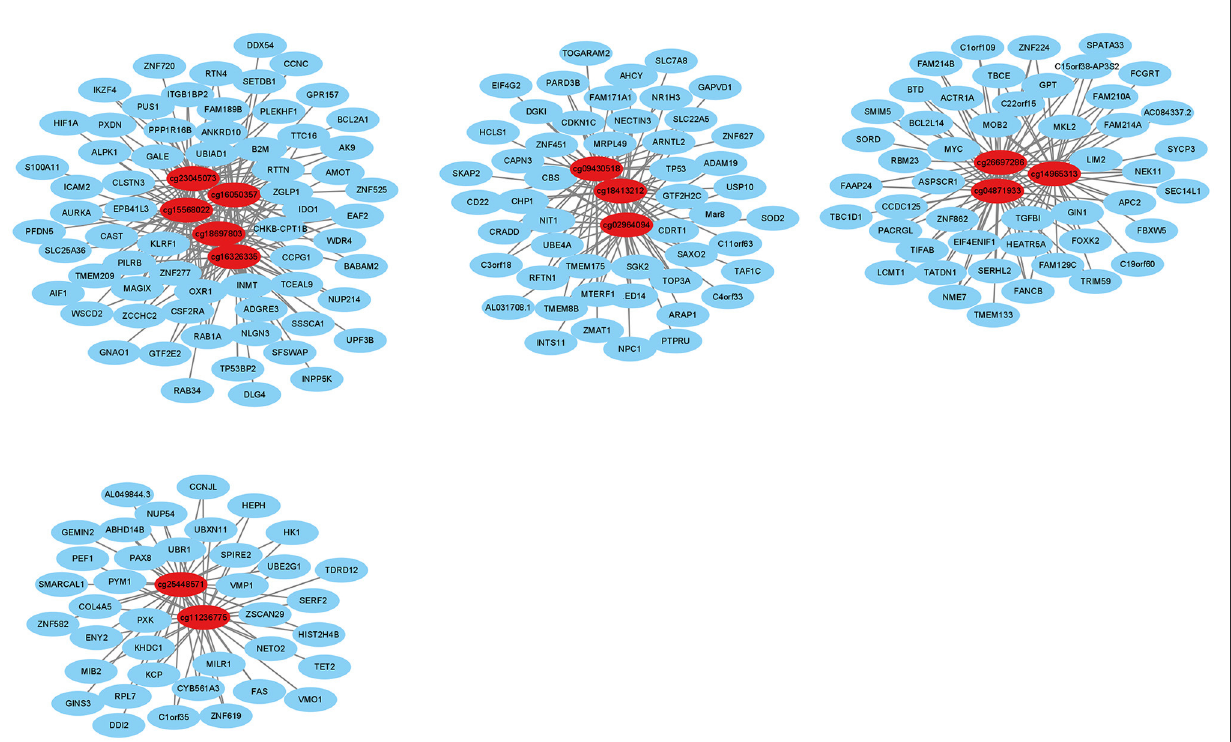
FIGURE6 Interactions between differentially expressed DNA methylation positions and mRNAs. The red dots indicate DNA methylation positions, and the blue dots indicate mRNAs.